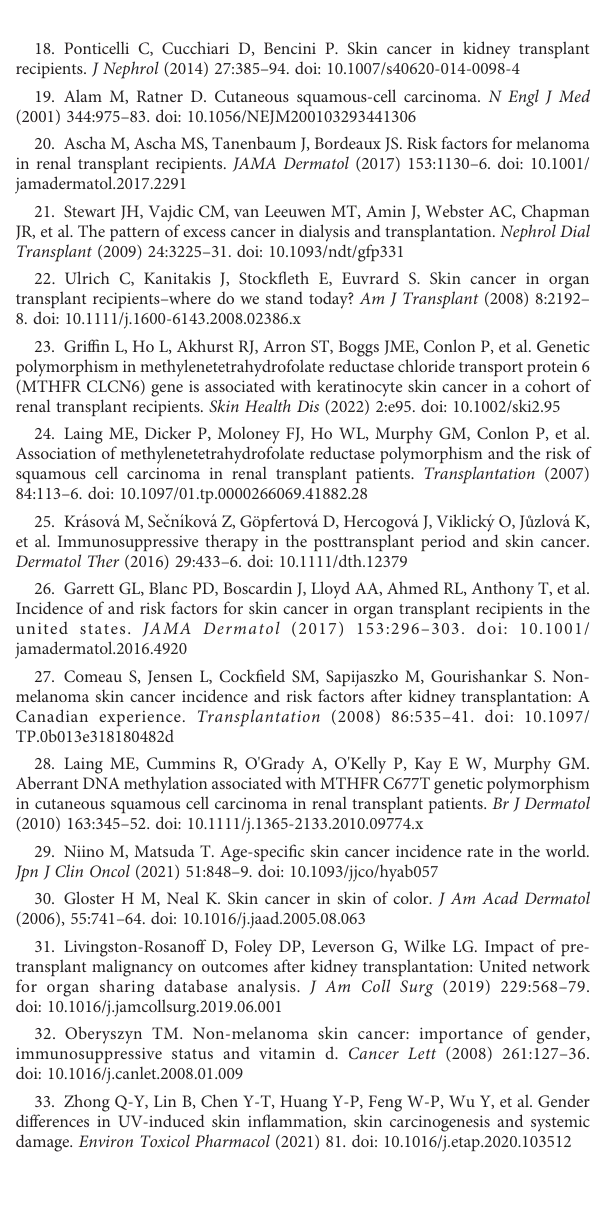
SUPPLEMENTARY TABLE 1 Recipient ethnicity and donor type in patient received caucasian donor